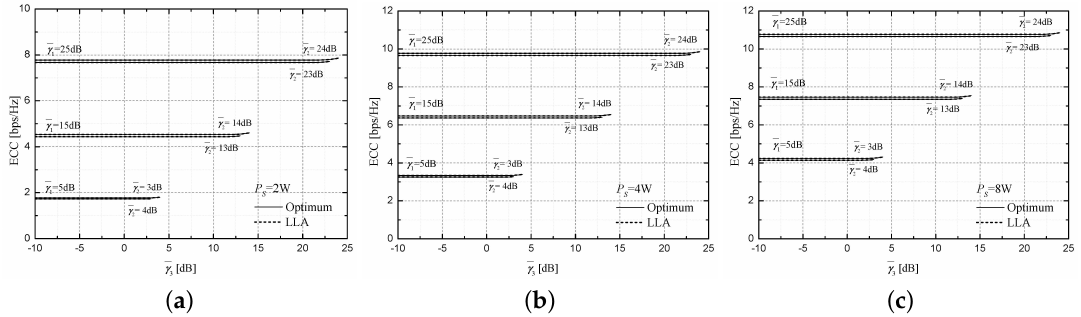
Figure 6. ECCs of the Co3P JDT network as a function of ¯ γ 3 [dB], with ¯ γ 1 [dB] and ¯ γ 2 [dB] as parameters: ( a ) P S = 2 W, ( b ) P S = 4 W, ( c ) P S = 8 W.